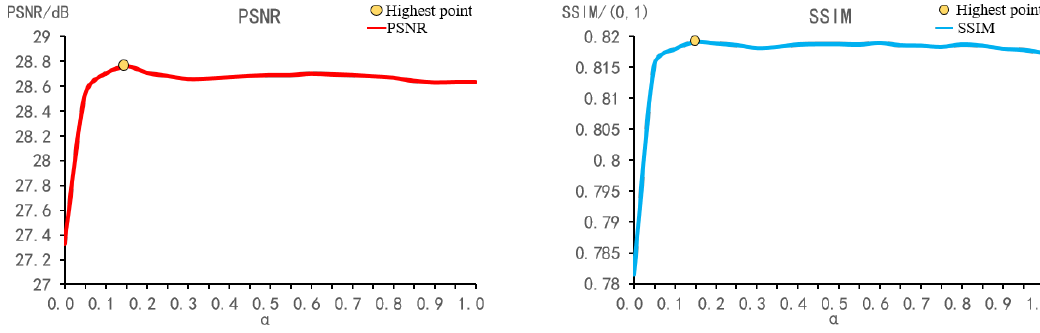
Figure 3. The curves of PSNR and structural similarity (SSIM) values versus different α values. The point corresponding to the highest PSNR or SSIM value has been